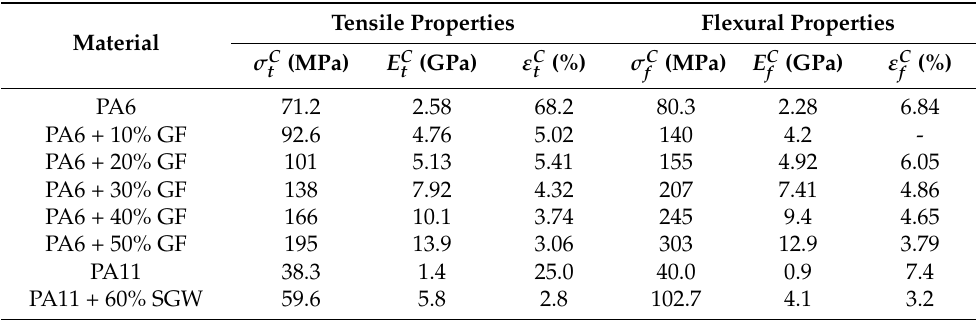
Table 1. Tensile and flexural properties of glass fibre-reinforced Polyamide 6 composites and stone- ground wood (SGW)-reinforced Polyamide 11 composites.